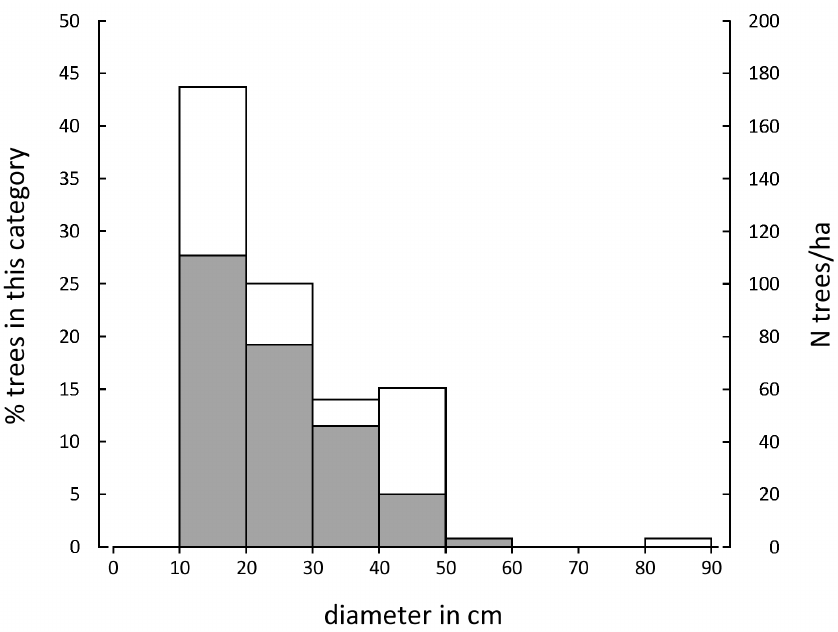
Figure 4. Quantitative assessment. Percentage of trees (N = 119) in classes with diameters of 10 cm dif- ferences and estimated numbers per ha. Grey for Albizia. Cooun, Drabo Gbo,